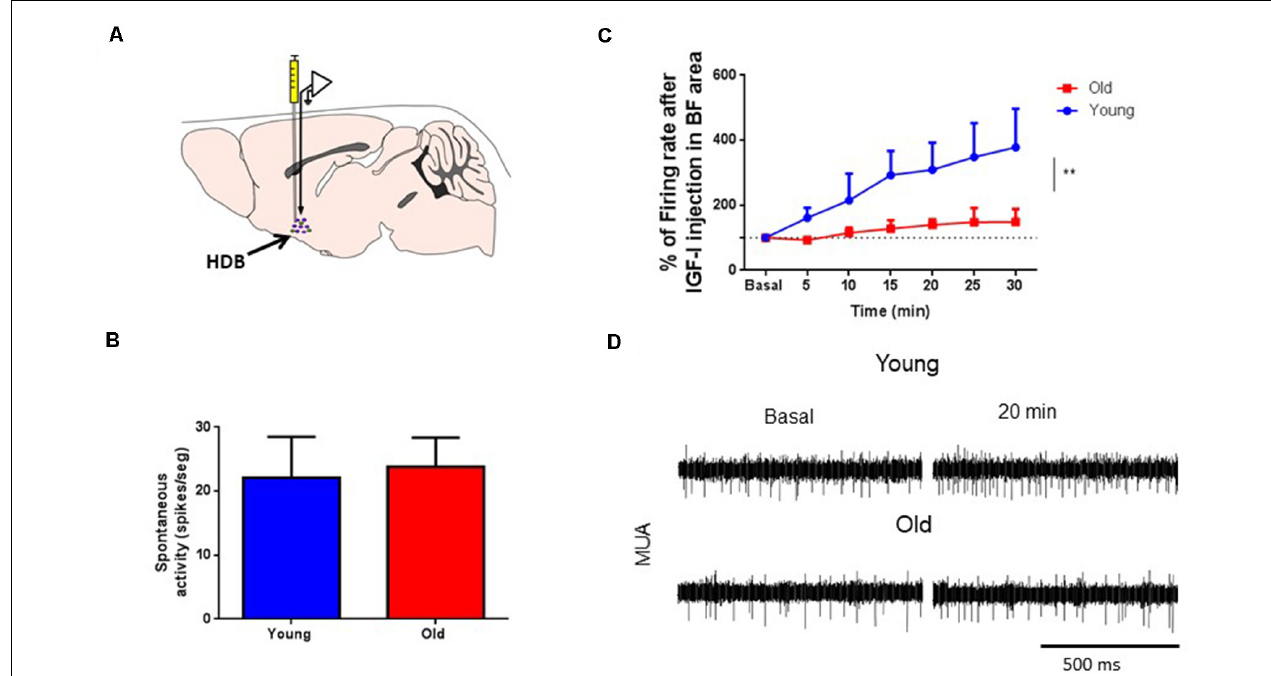
FIGURE 3 | IGF-I increased multiunit (MUA) activity in HDB neurons. (A) Schematic diagram of the experimental design. A recording microelectrode was sited in the HDB area (arrow); a cannula to inject IGF-I (10 nM; 0.2 µ l) was also placed in the same area. (B) Plot of the spontaneous activity in young and old mice. No differences were found in MUA recordings at basal condition (young 22.09 ± 6.41 spikes/s, n = 17; old 23.81 ± 4.60 spikes/s, n = 9; p = 0.2863; sex balanced, Mann–Whitney test). (C) Time course of the HDB firing rate after IGF-I local injection. The firing rate of MUA is expressed as a percentage of basal responses at time 0 in both experimental groups. Young but not old mice responded to IGF-I in HDB nucleus (young, n = 14; old, n = 6; F (1,122) = 8,433; ** p = 0.0044; Ordinary Two-way ANOVA). (D) Representative Multi-unitary recordings (MUA) at basal and 20 min after IGF-I in both young and old mice. The bar represents 500